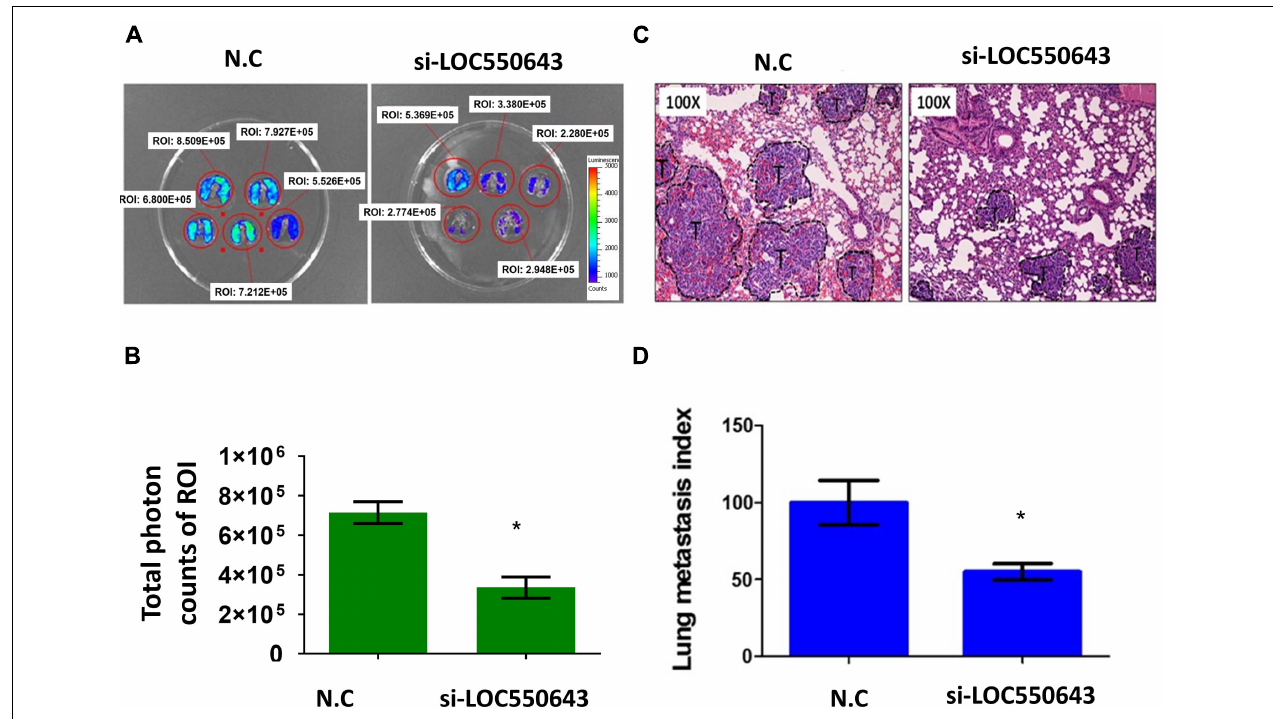
FIGURE 7 | Suppression of the lung metastasis potential of MDA-MB-231-IV2-1 cells through LOC550643 depletion. (A) Lung metastatic ability of si- LOC550643 and N.C control MDA-MB-231-IV2-1 cells examined using the SCID mice model through intravenous injection. Ten SCID mice were used (five as controls and five with LOC550643 knockdown). Three weeks after injection, lung metastasis status was assessed using IVIS. (B) ROI intensity calculated and analyzed using Student’s t -test. (C) Metastatic lungs examined using H&E staining. (D) Lung metastasis index assessed using Student’s t -test. * p <